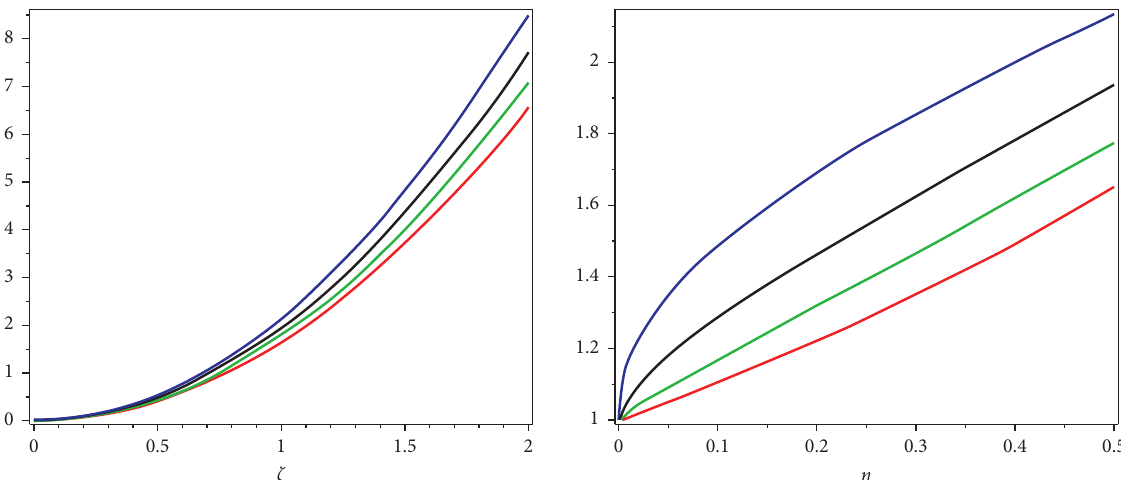
Figure 5: The approximate solution graph of problem 4.1, at different fractional order of δ � 1 with respect to ζ and η .